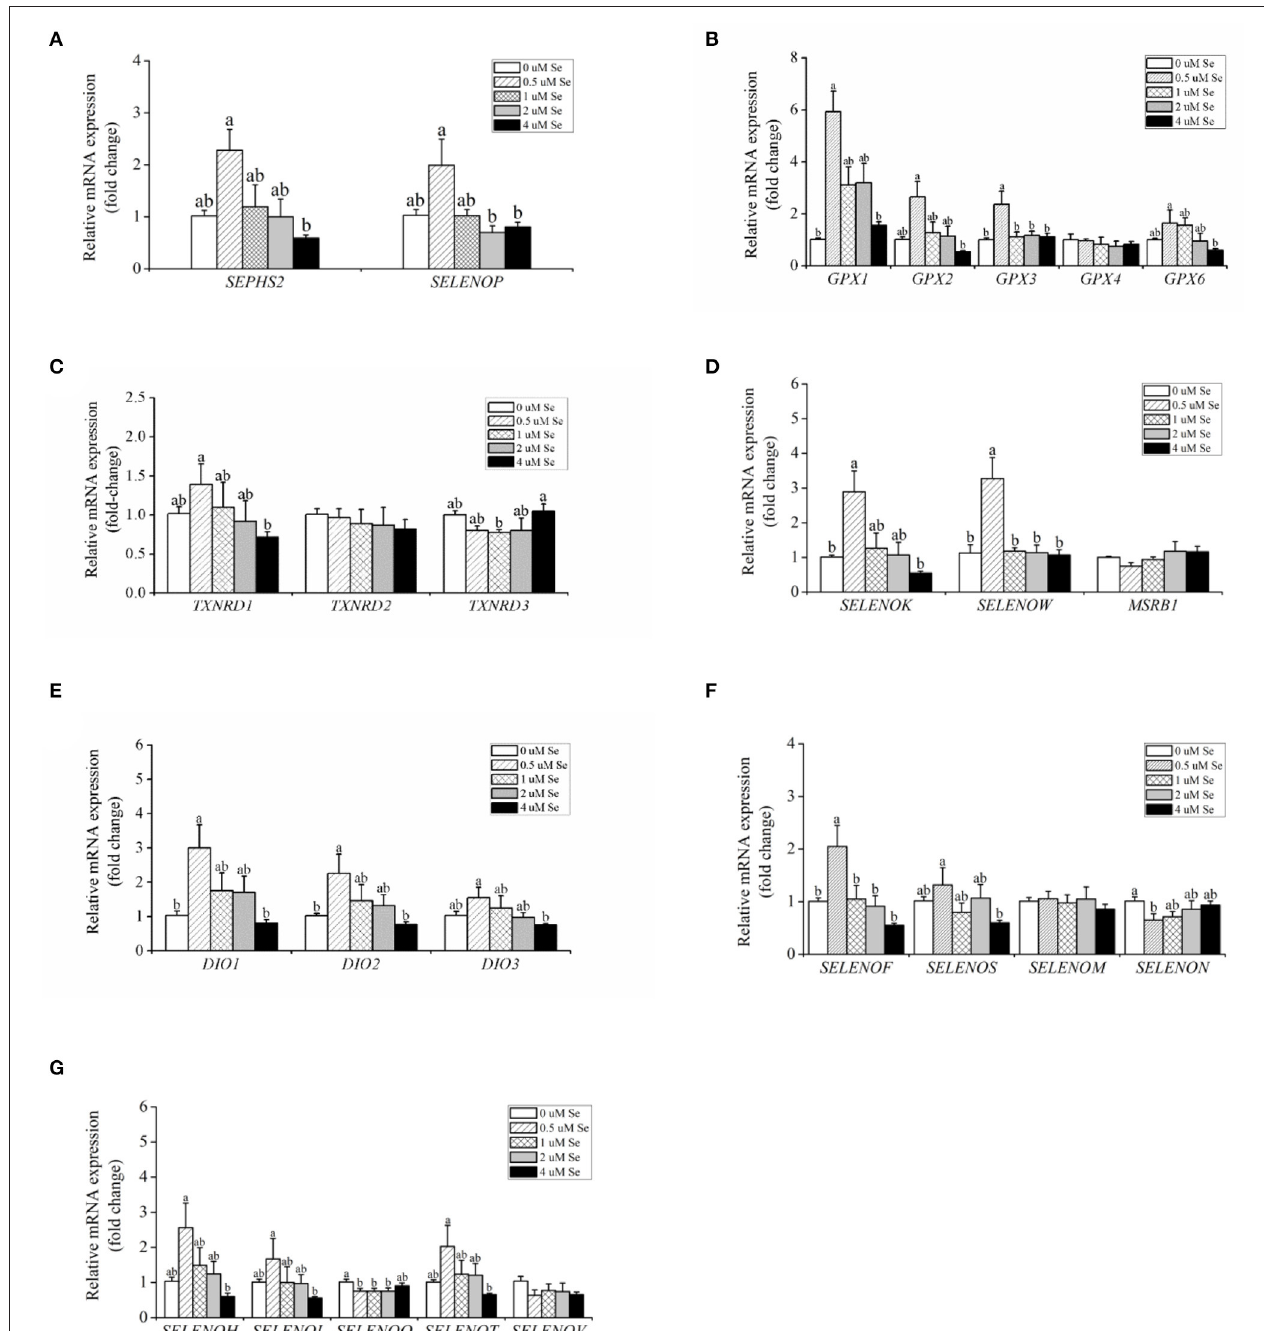
FIGURE 3 | Effects of selenomethionine (Se-Met) supplementation on the relative mRNA expression of 25 selenoproteins in porcine mammary epithelial cells (pMECs). (A) selenoprotein SEPHS2 and SELENOP ; (B) the selenoprotein GPX family; (C) the selenoprotein TXNRD family; (D) antioxidant selenoproteins; (E) the selenoprotein DIO family; (F) protein-fold function selenoproteins; (G) other unknown functions of selenoproteins. The cells were incubated for 48h with different concentrations of Se-Met (0, 0.5, 1, 2, and 4 µ M) and then collected for determination of mRNA expression. The data are expressed as the mean ± SEM ( n = 6). Different superscript letters indicate a significant difference ( p <